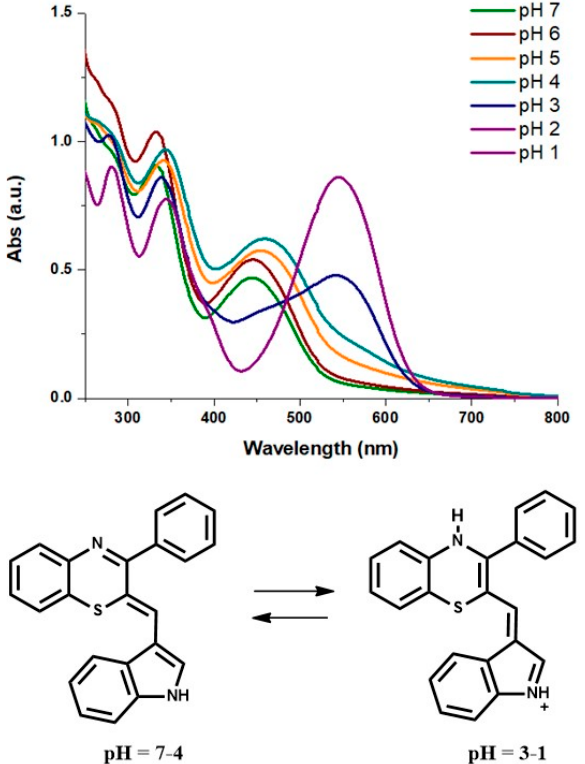
Figure 3. Top : UV-vis absorption spectra of cyanine 1 dissolved in methanol and diluted to 0.1 mM in 50 mM sodium phosphate buffer at different pHs. Bottom : protonation equilibrium of cyanine 1 .